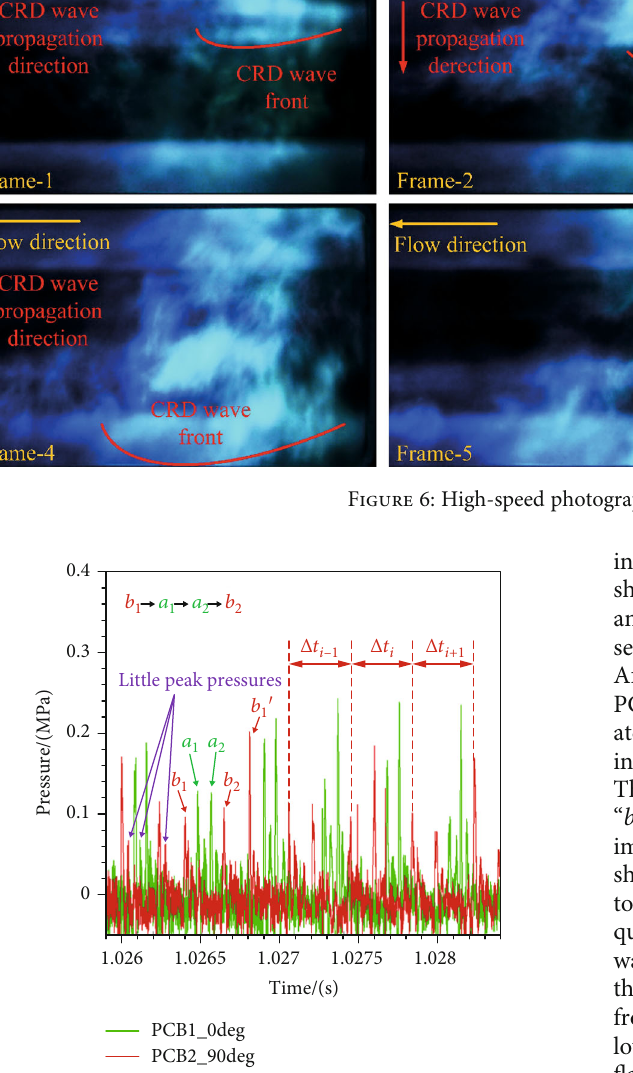
Figure 7: Local view of high-frequency dynamic pressures of Test